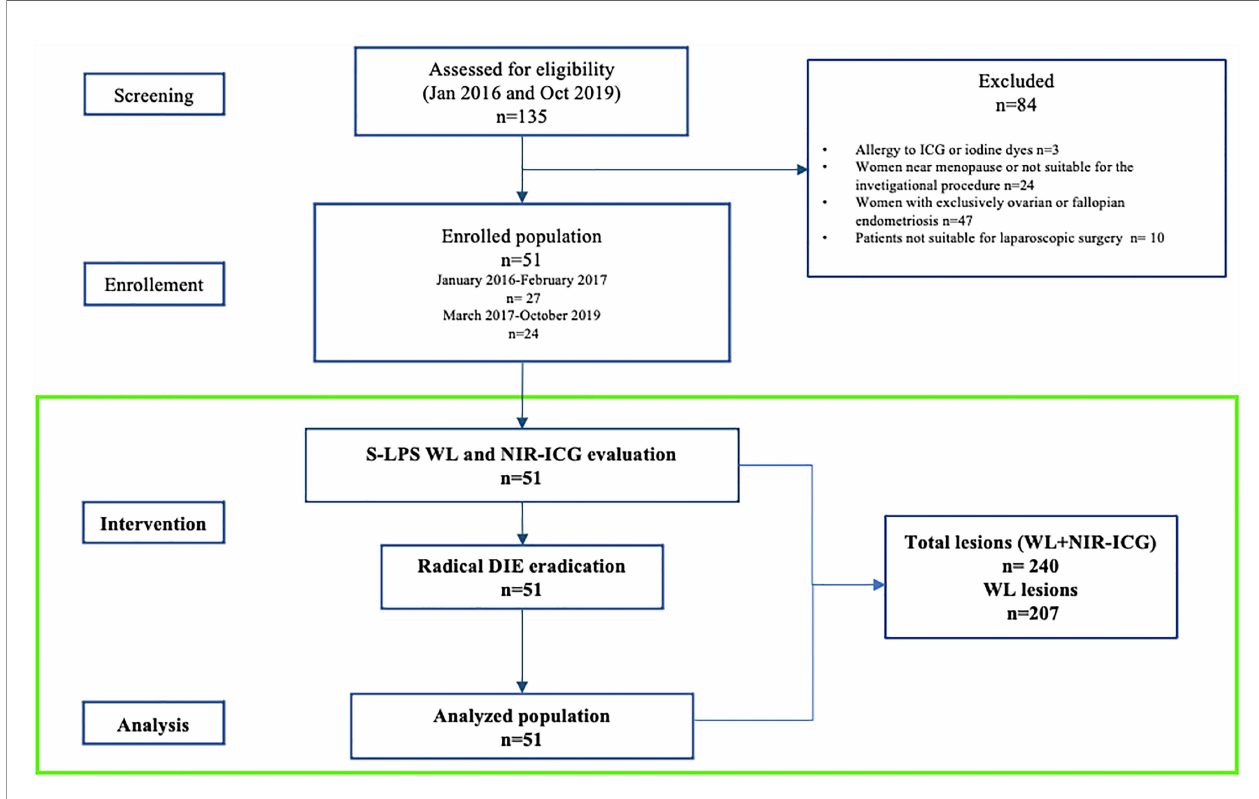
FIGURE 2 | Study fl ow